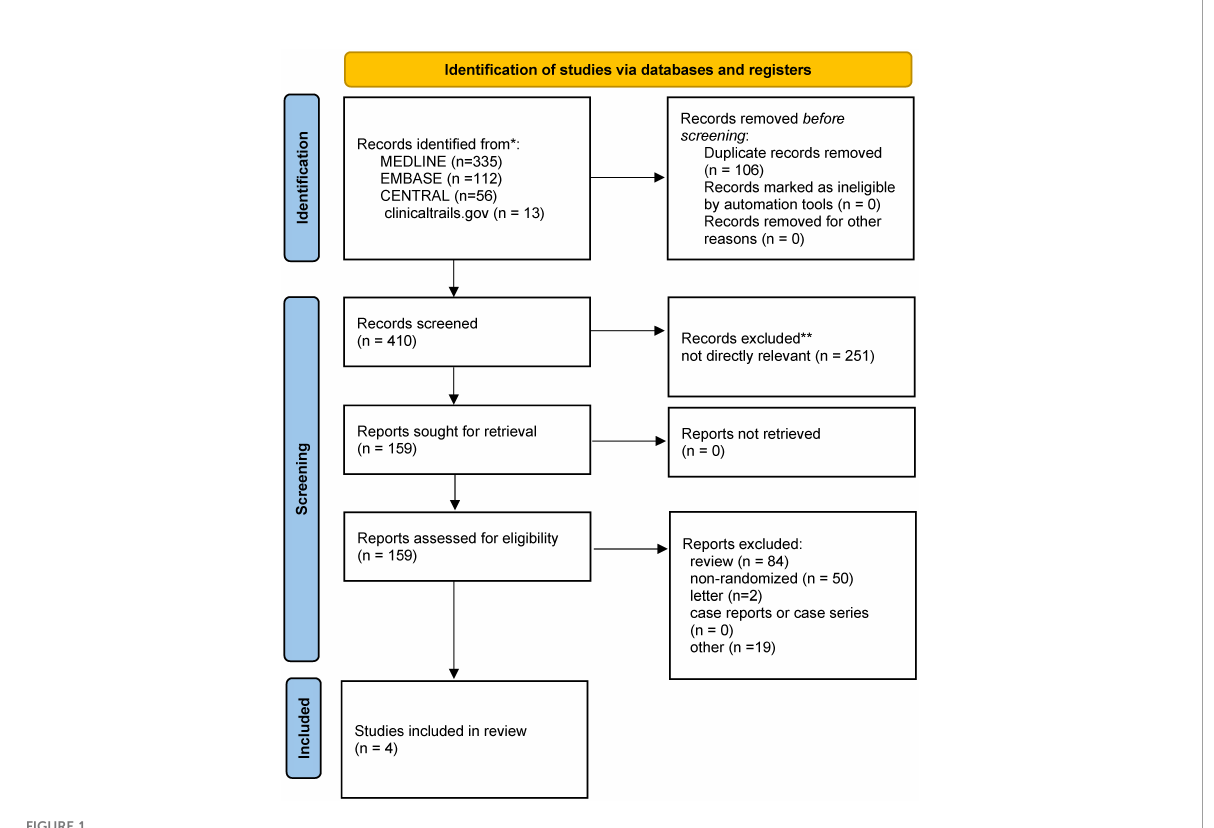
FIGURE 1 PRISMA fl ow diagram of study